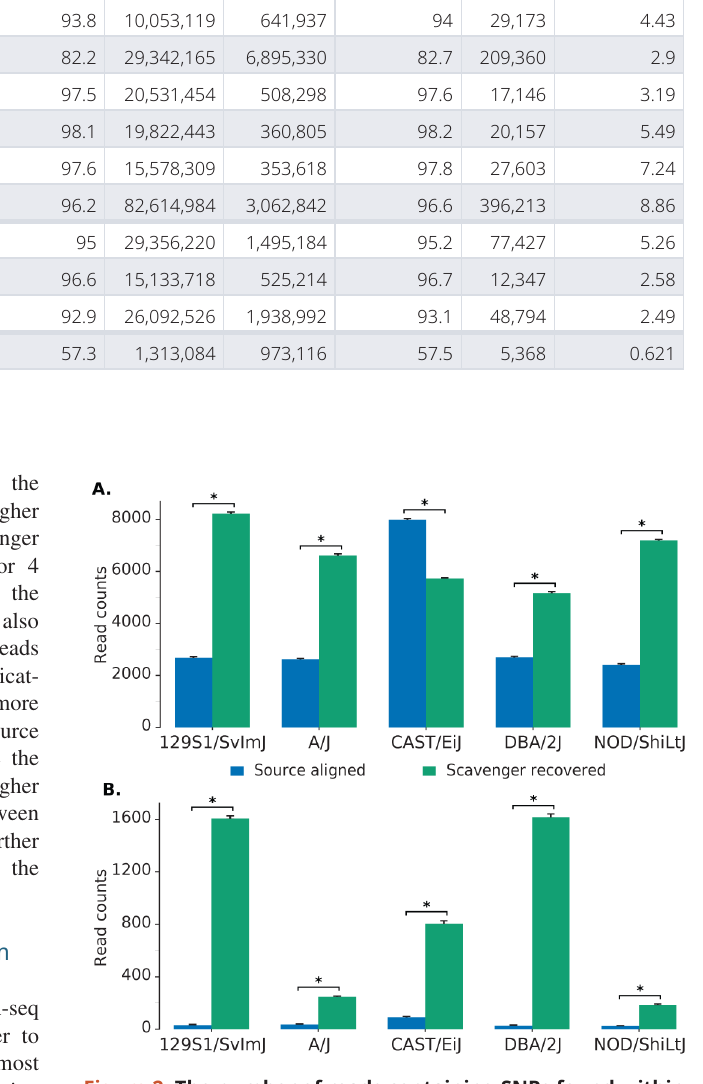
Figure 2. The number of reads containing SNPs found within source aligned reads and Scavenger recovered reads. A . The number of reads with ≥ 1 SNPs found within reads. B . The number of reads with high number of SNPs (> 5) found within reads.